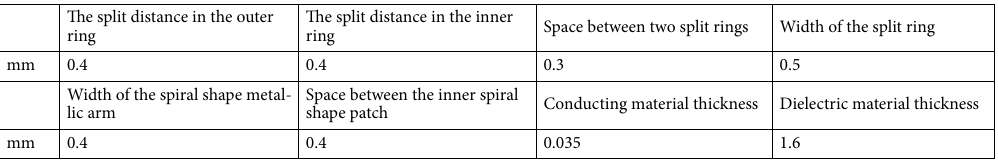
Table 1. Dimensional specification for the proposed metamaterial unit cell.